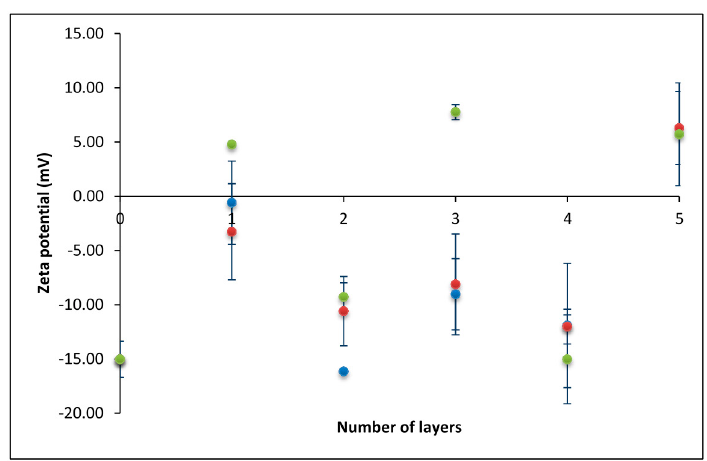
Figure 1. The dependence of zeta-potential on the number of polyelectrolyte layers obtained at three different polyelectrolyte concentrations. c (PAH) = c (PSS) = 0.001 mol · dm − 3 ( blue dots ); c (PAH) = c (PSS) = 0.003 mol · dm − 3 ( red dots ); and c (PAH) = c (PSS) = 0.01 mol · dm − 3 ( green dots ). PAH: poly(allylamine hydrochloride); PSS: sodium poly(4-styrenesulfonate).